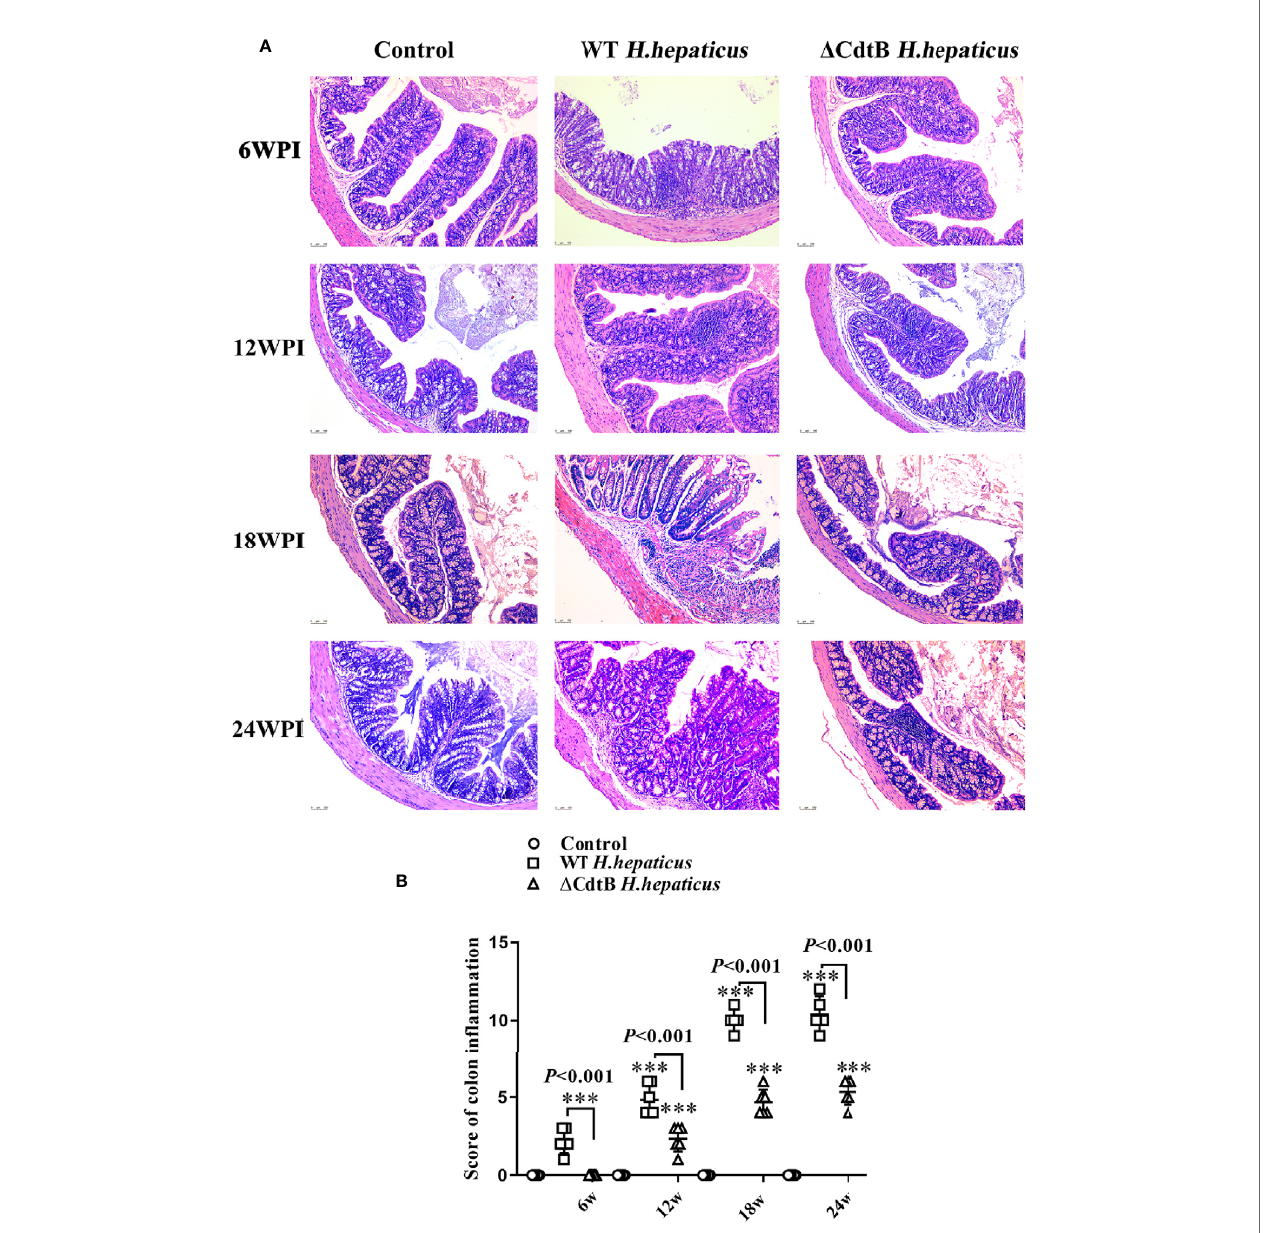
FIGURE 3 | The colonic mucosa of colitic mice was attenuated by CdtB mutant. (A) Sections of the colonic mucosa were stained with hematoxylin and eosin (×100). At 6 WPI, the control colonic mucosa was integrated, crypts and goblet cells were evenly distributed, and a few scattered lymphocytes were found in submucosa; but WT H. hepaticus induced mild mononuclear cell in fi ltrates in lamina propria accompanied by slight depletion of mucus from goblet cells. At 12 WPI, D CdtB H. hepaticus induced a few multifocal mononuclear cell in fi ltrates in the lamina propria accompanied by slight to no depletion of mucus from goblet cells; while, WT H. hepaticus induced mild in fl ammatory cell in fi ltrates in the lamina propria accompanied by depletion of mucus from goblet cells. During the 18 – 24 WPI, the change of colonic symptoms caused by D CdtB H. hepaticus was not obvious; but WT H. hepaticus induced progressive colitic symptoms, including moderate lamina propria or submucosa in fl ammation, mucin depletion, crypts abscesses or hyperplasia and enlargement, etc. (B) Microscopic scores were assigned to the different groups according to the criteria described (Erdman et al., 2009). Data are expressed as the means ± SEM (n = 5/group). *** P < 0.001 when compared with the control